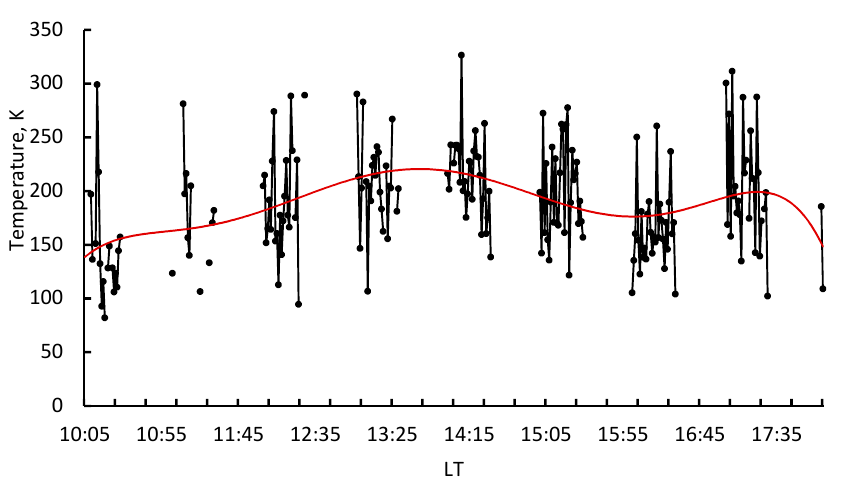
Figure 10. Time dependence of the neutral component temperature for 11 September 2019. Each dot on the graph is obtained by averaging data over 1 min.